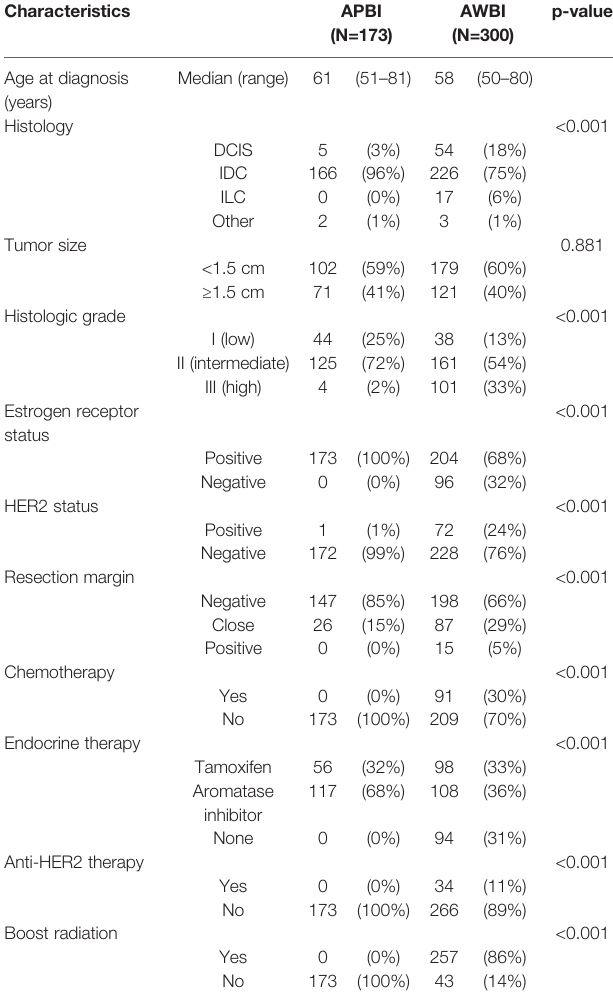
TABLE 1 | Patient, treatment, and tumor-related characteristics of all